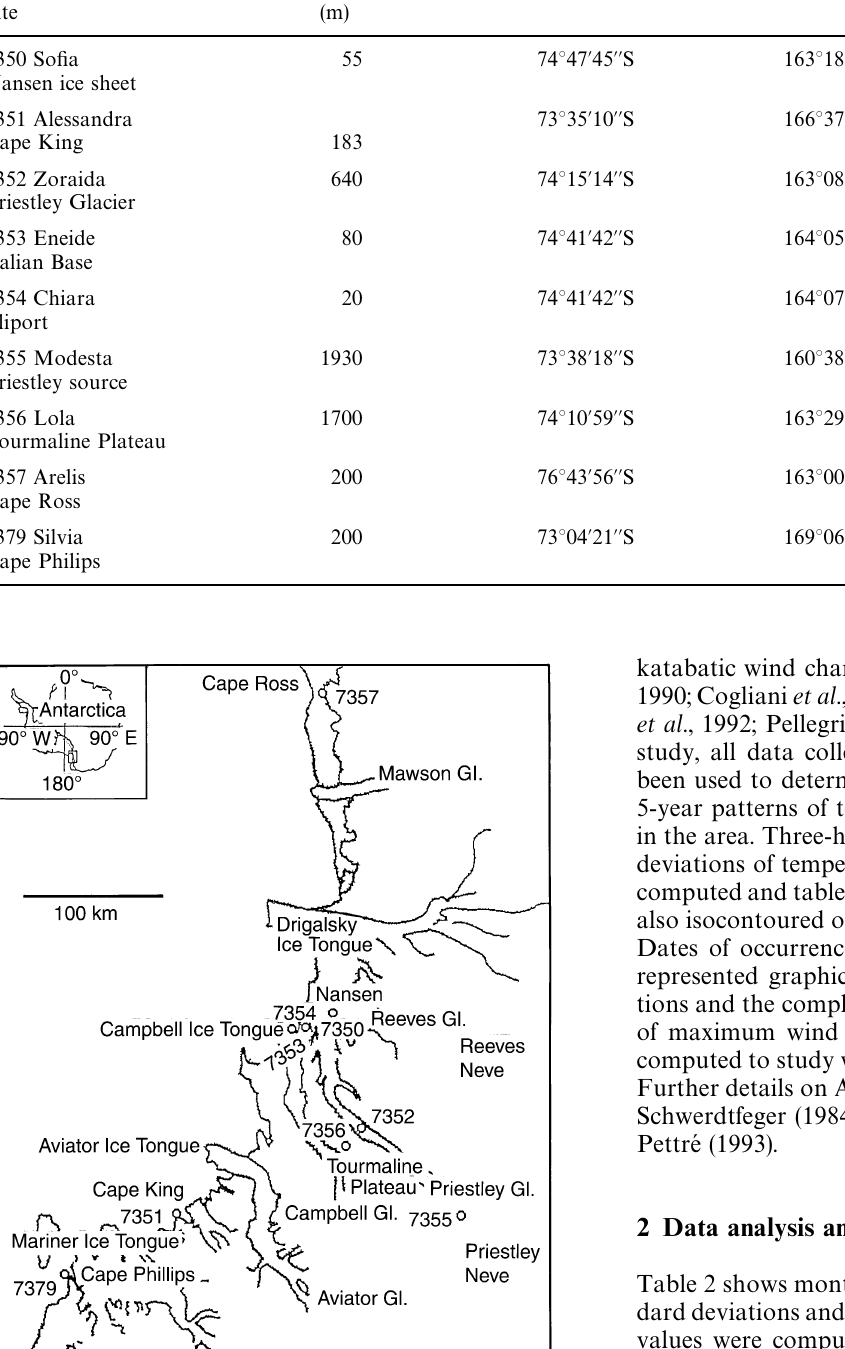
Table 1. Italian AWS (automatic weather stations) in Antarctica AWS ID No. (name)